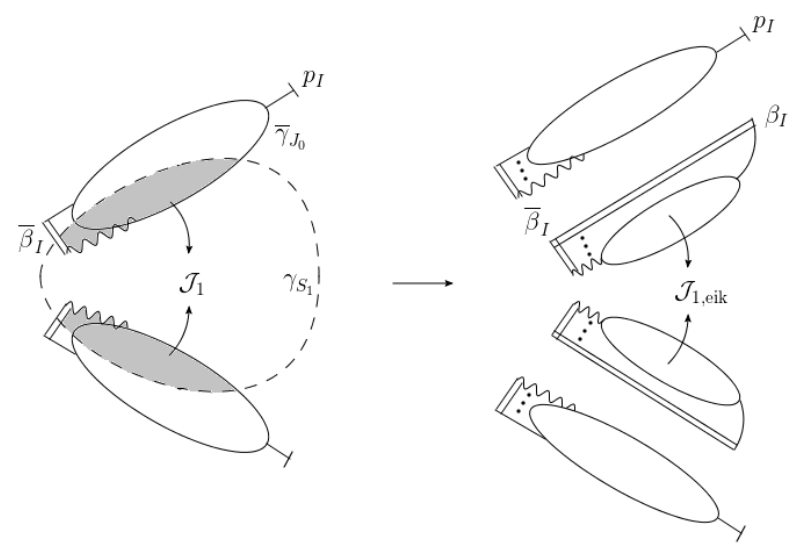
, (cid:13) J 0 S 1 may have a nonzero intersection S 1